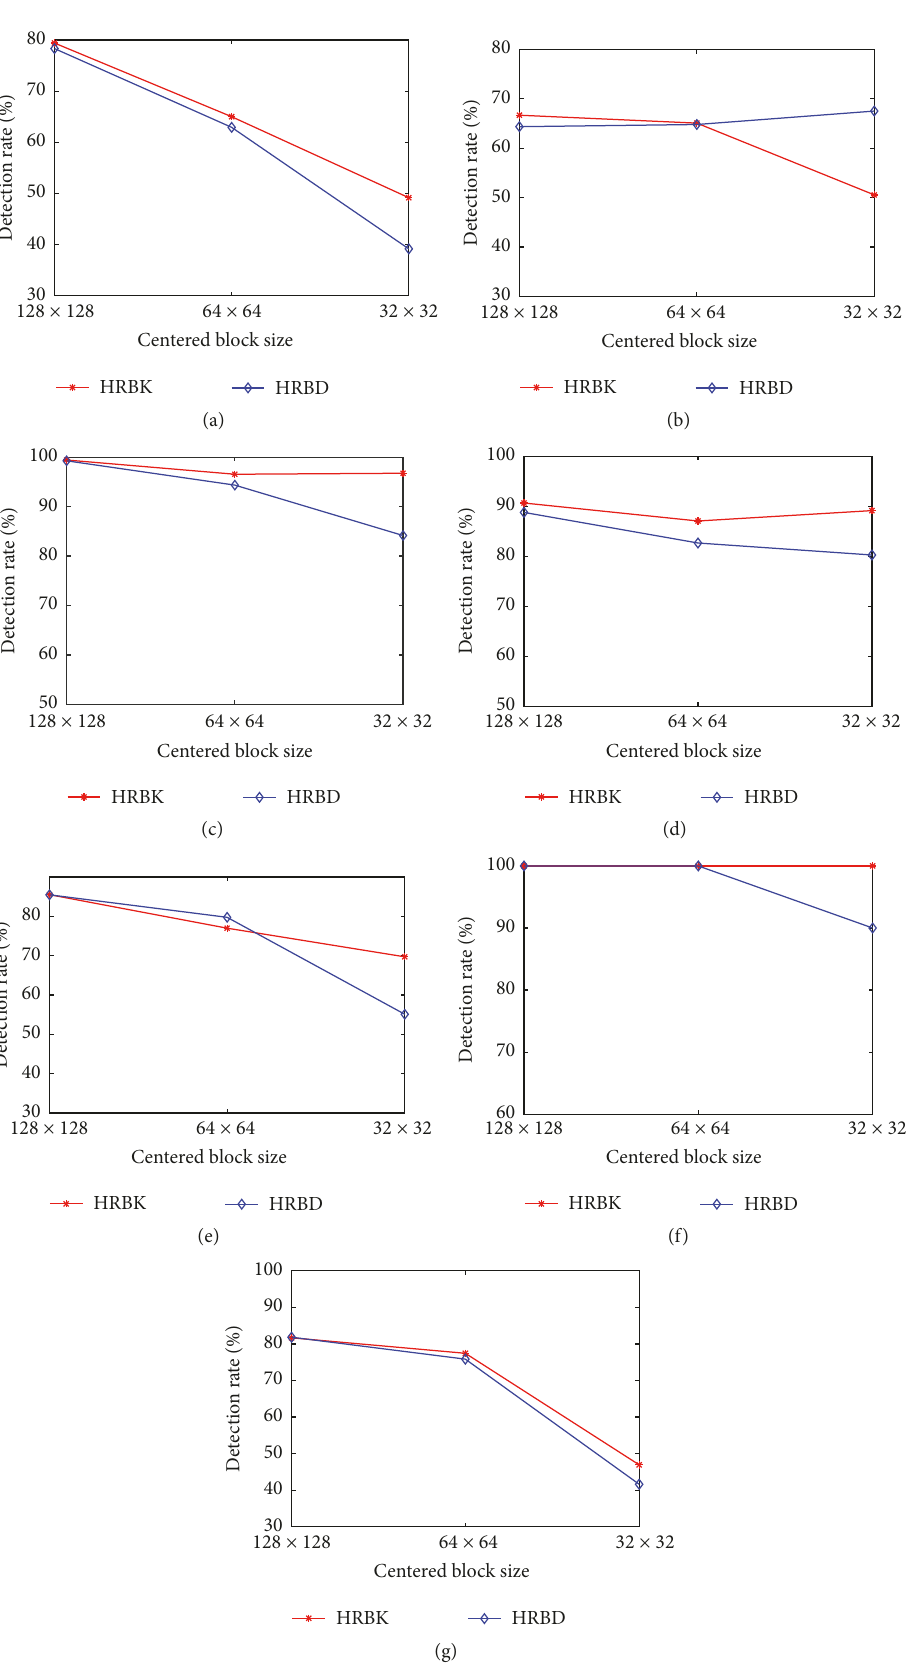
Figure7:MRimagemodificationdetectionratesfordifferentcenteredblocksizesandvariousmodificationtypes:(a)JPEG2000,(b)Gaussian filtering, (c) Laplacian filtering, (d) brightening, (e) scaling, (f) histogram equalization, (g) JPEG